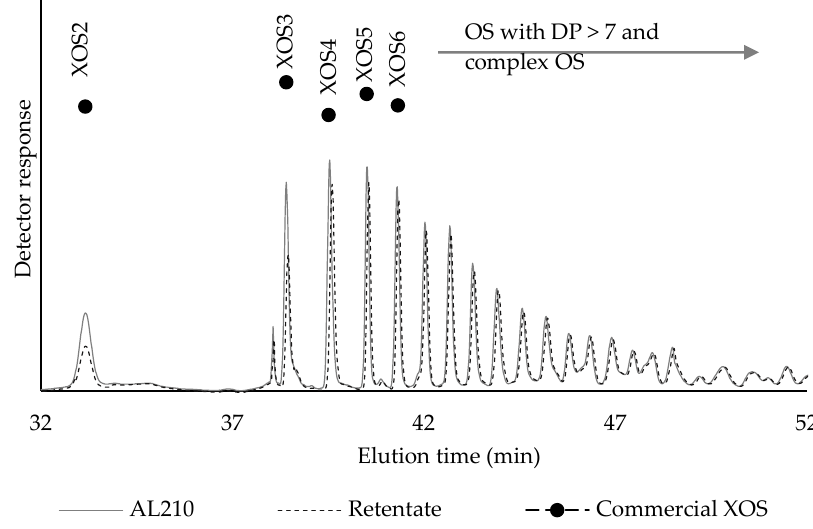
Figure 3. HPAEC–PAD elution profiles for the autohydrolysis liquors at 210 °C and retentate.